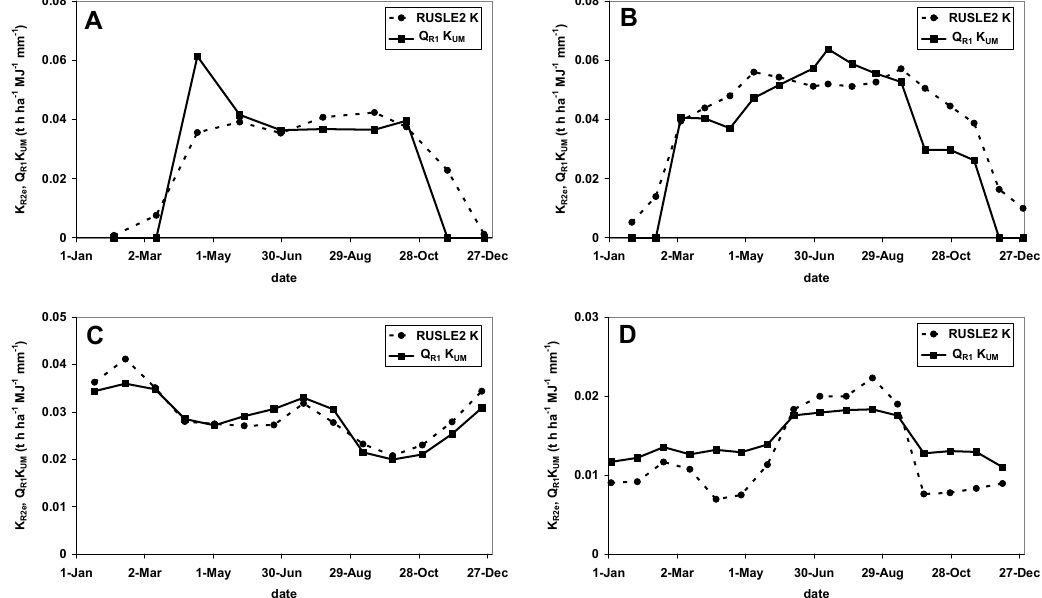
Figure 3. Storm RUSLE2 K and Q R1 K UM values for unit plots at ( A ) Presque Isle, ME, Caribou gravelly loam soil; ( B ) Bethany, MO, Shelby loam soil; ( C ) Macon, Georgia (GA), Tifton soil; and ( D ) Tampa, Florida (FL), Leon fine sand (source: Kinnell [18]).